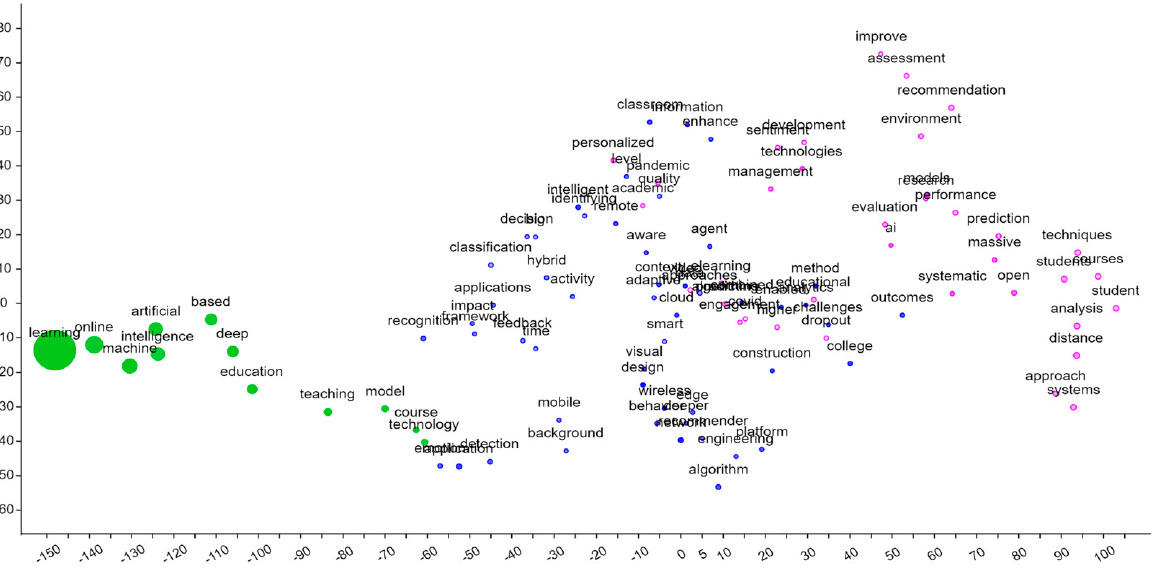
Figure 4. t-SNE analysis of the titles of the sampled publications.